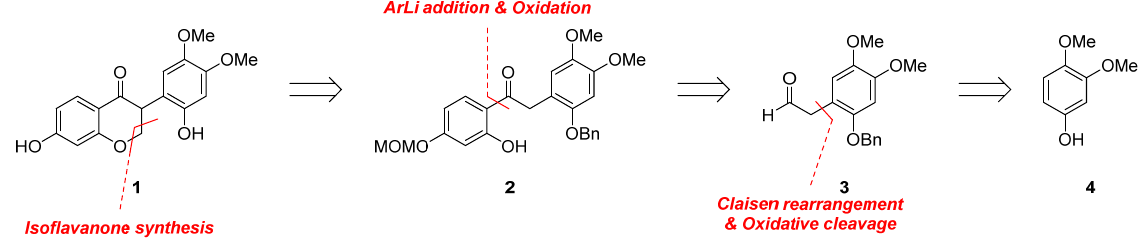
Figure 2. Retrosynthetic analysis of 7,2 ′ -dihydroxy-4 ′ ,5 ′ -dimethoxyisoflavanone ( 1 ).